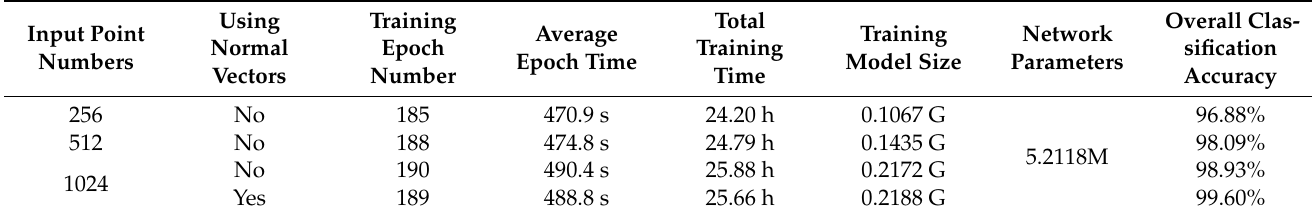
Table 2. The experimental results of MFPointNet.